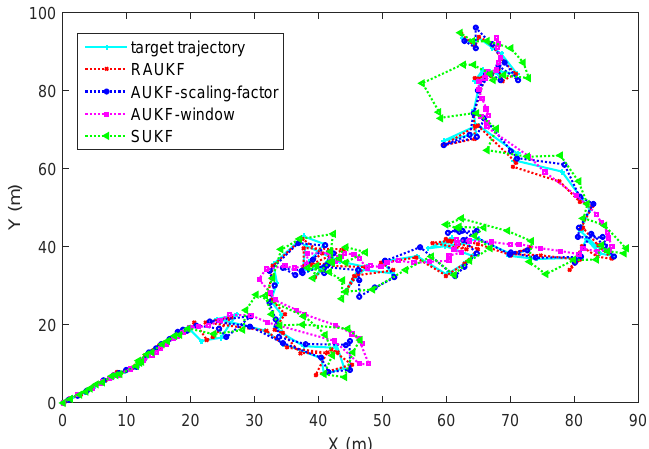
Figure 3. Comparison of state estimation results of different algorithms before and after an abrupt ( v ) change of the Q k